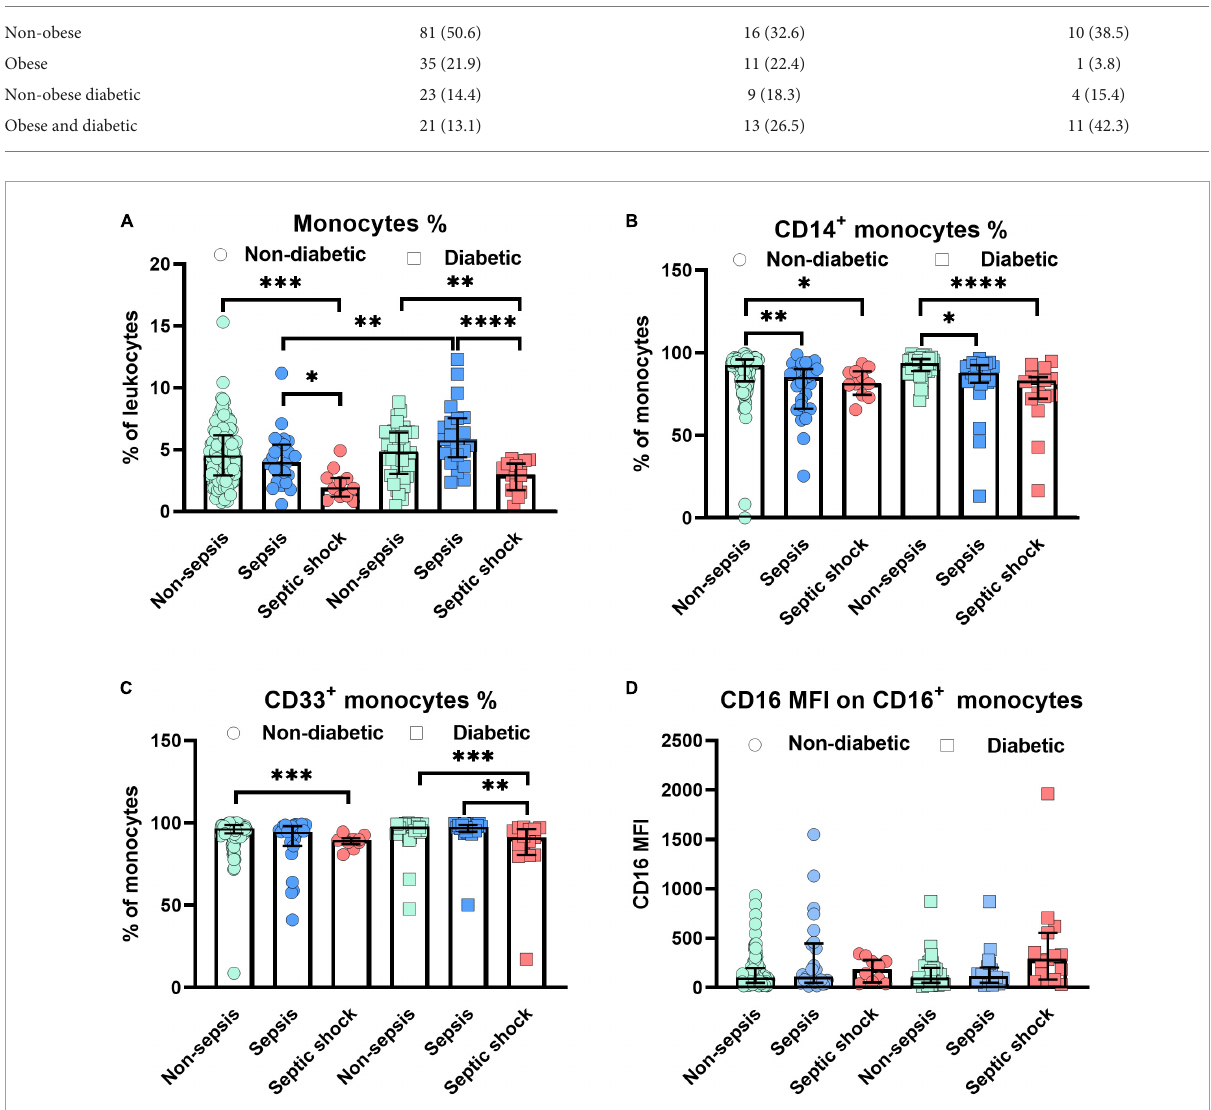
FIGURE1 Alterations of monocytes in non-diabetic/diabetic patients with distinct degrees of sepsis severity. Distribution changes in the percentage of monocytes among the total leukocyte population (A) and the percentage of CD14 + monocytes (B) and CD33 + monocytes among the monocyte population (C) . (D) Surface phenotype expression of CD16 on positive monocytes determined by mean fluorescence intensity (MFI). Data are presented by scatter with bar plots. Results are medians with interquartile range. Kruskal–Wallis test and Mann–Whitney U -test were, respectively, used to analyze the differences among three groups and two groups. Significant difference is marked by ∗ p < 0.05, ∗∗ p < 0.01, ∗∗∗ p < 0.001, and ∗∗∗∗ p <